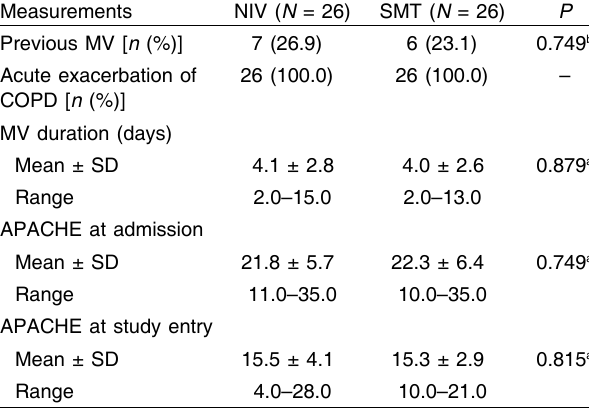
Table 2 Comparison between the study groups as regards clinical respiratory